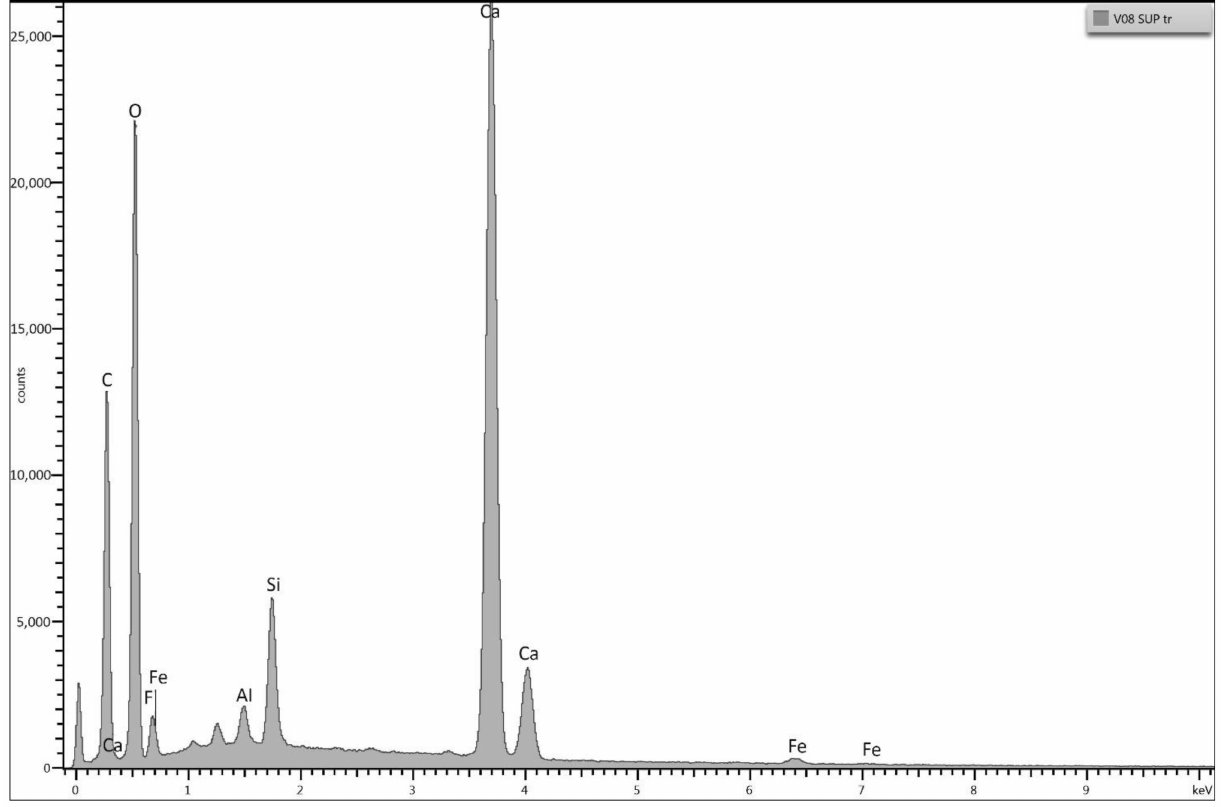
Figure 7. Elemental analysis in SEM-EDS: sample treated with NSO (University of Bari Aldo